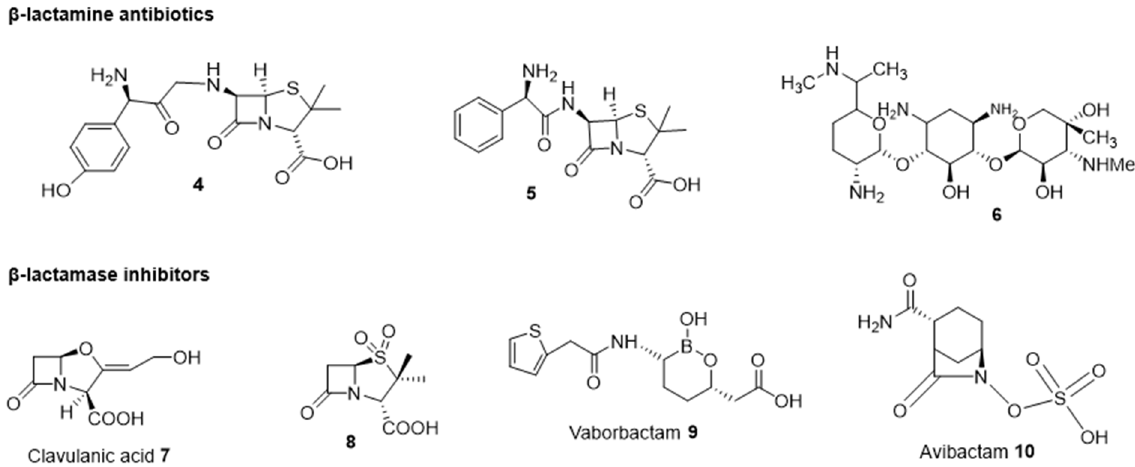
Figure 3 . Structure of β -lactam antibiotics 4 - 6 and β -lactamase inhibitors 7 - 10